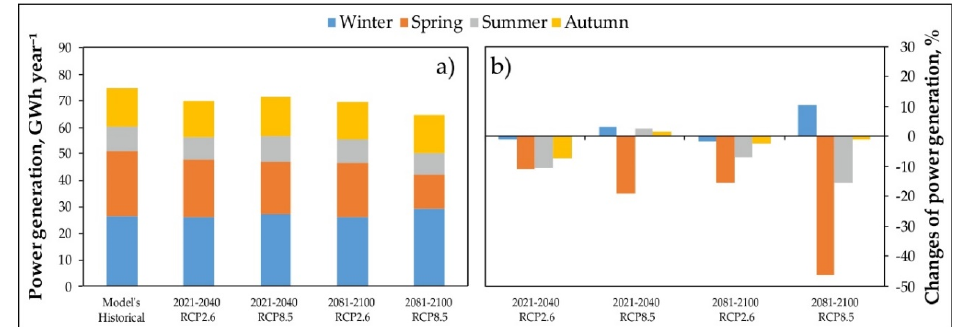
Figure 8. Projection of seasonal energy production in small Lithuanian hydropower plants in the near and far future ( a ) and its change compared to 1986–2005 ( b ). and far future ( a ) and its change compared to 1986–2005 ( b